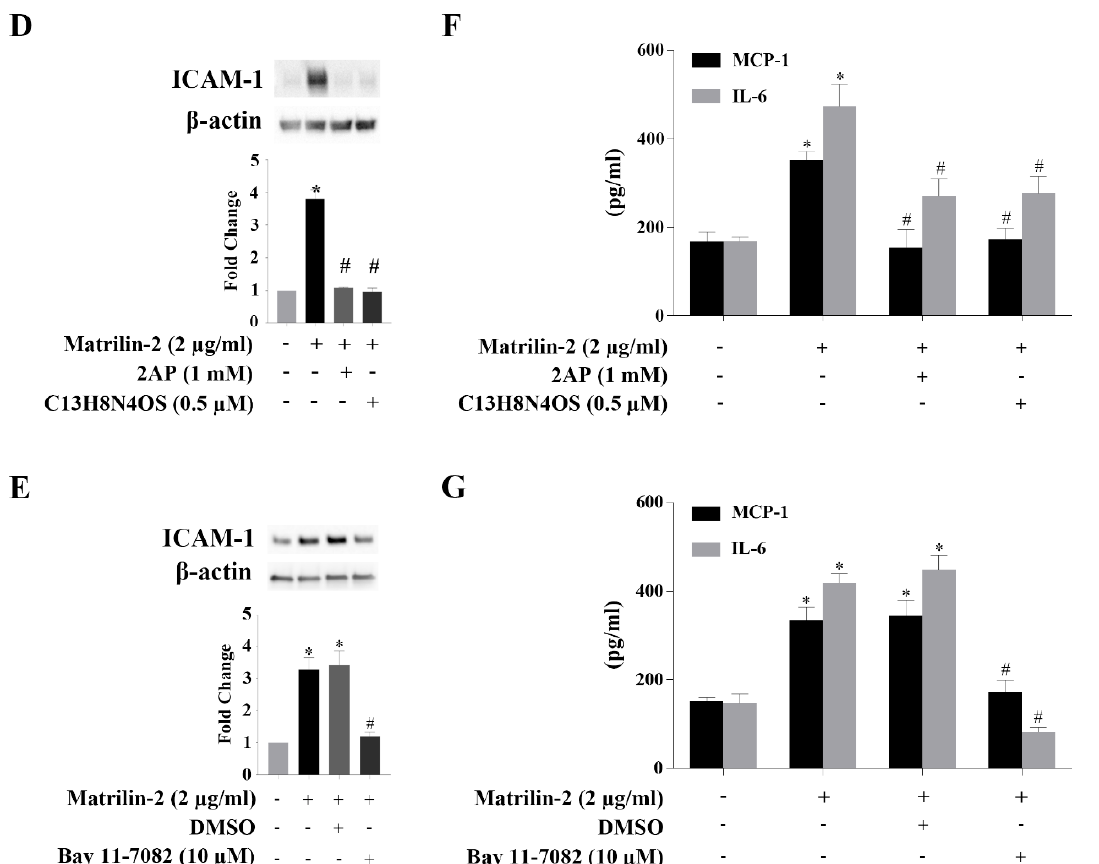
Figure 3. Both PKR and NF- κ B are critical for AVIC inflammatory responses induced by matrilin-2, and PKR is responsible for NF- κ B activation. Human AVICs were treated with PKR inhibitors (C 13 H 8 N 4 OS and 2-AP) or NF- κ B inhibitor (Bay 11-7082) for 1 h or left untreated, followed by stimulation with recombinant matrilin-2 for 1 h or 48 h. ( A , B ) Inhibition of PKR suppressed NF- κ B phosphorylation. ( C ) Nuclear translocation of NF- κ B was inhibited by PKR inhibitors. Representative images of immunofluorescence staining show NF- κ B (red) in human AVICs. Alexa 488–tagged wheat germ agglutinin (WGA) was applied to outline plasma membrane (green). DAPI (4 (cid:48) ,6-diamidino-2-phenylindole) was applied for nuclei counterstaining (blue). Original magnification, × 40 objective. ( D , E ) Inhibition of PKR or NF- κ B markedly reduced ICAM-1 production following matrilin-2 stimulation. ( F , G ) PKR and NF- κ B inhibitors markedly reduced MCP-1 and IL-6 release following stimulation with matrilin-2. Values are means ± SE. n = 5 experiments using distinct cell isolates; * P < 0.05 vs. control; # P < 0.05 vs. matrilin-2